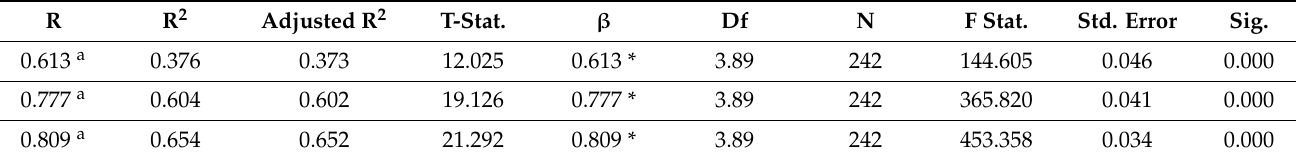
Table 2. Hypotheses